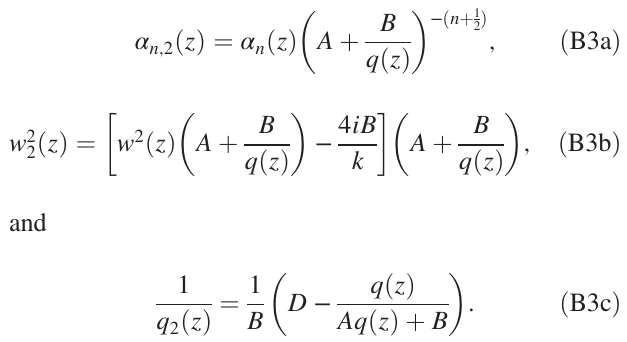
ffiffiffiffiffiffiffiffiffiffiffiffiffiffiffiffiffiffiffiffiffiffiffiffiffiffiffiffiffiffiffi 1 − ð A þ D Þ 2 = 4